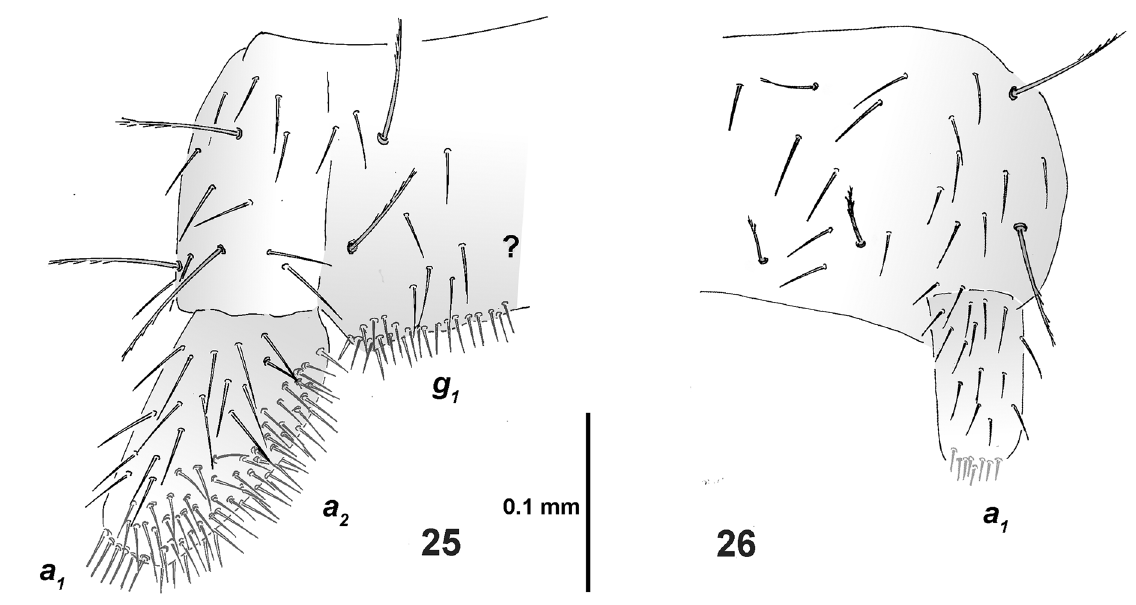
Figs 25−26. Kyrgyzstancampa sanare Sendra & Ferreira gen. et sp. nov., urosternite I, lateral side. 25 . ♂, paratype (MZB (MCNB) 2021-2339). 26 . ♀, paratype (MZB (MCNB) 2021-2338). Abbreviations: a = glandular setae in distal portion of appendages; a 1 glandular setae of